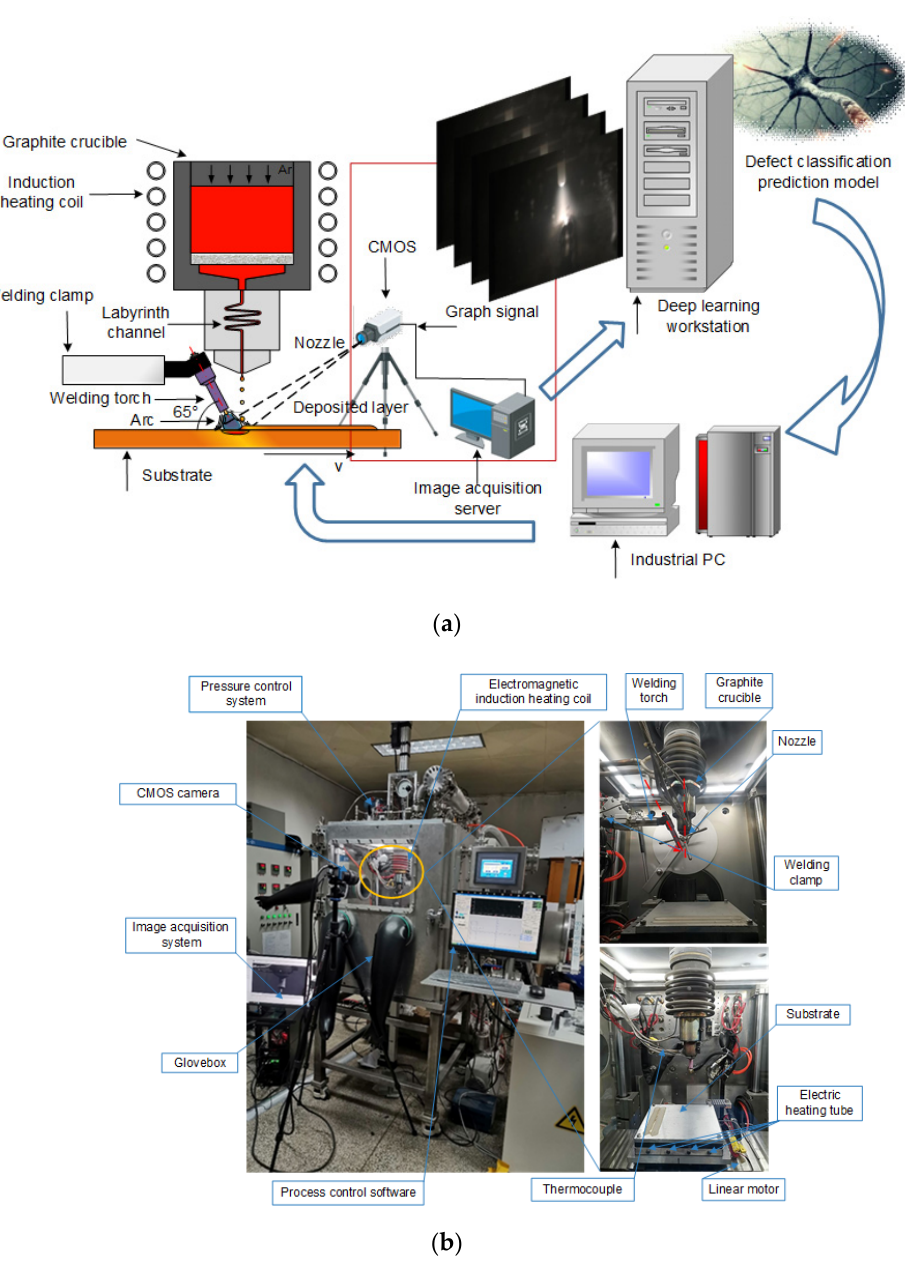
Figure 2. GTA-assisted DDM experiment platform. ( a ) Schematic diagram; ( b ) physical diagram. Table 1. The chemical composition of melted material